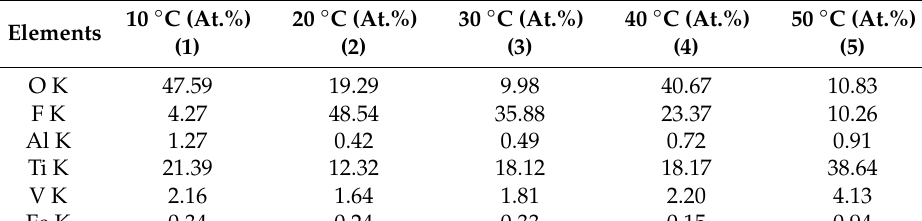
Table 2. The analysis results of corresponding EDS points in Figure 2.